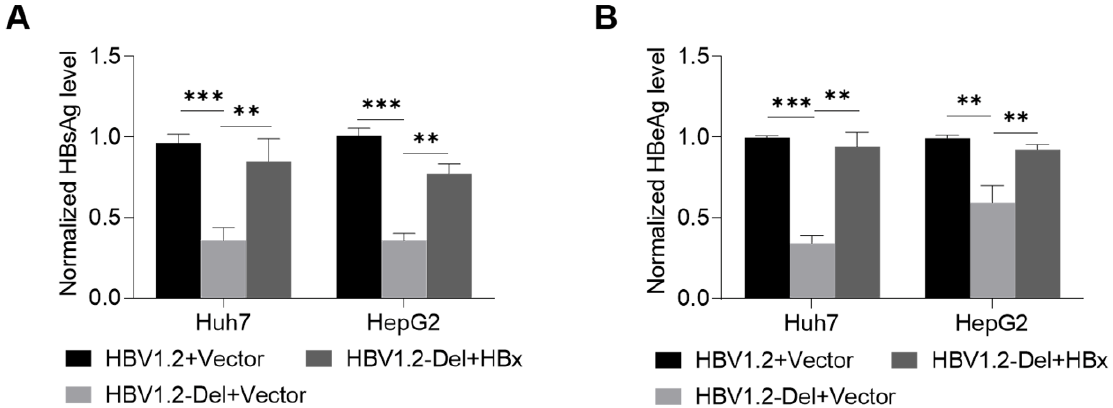
Figure 3. The effect of wild-type HBx protein on the x128–133del-weakened HBV replication. The pBB4.5-HBV1.2 or pBB4.5-HBV1.2-Del plasmid, pCDH-HBx-3 × flag or pCDH vector control plasmid, and pCDH-Nluc plasmid were co-transfected into the Huh7 and HepG2 cells (5 × 10 5 cells/well in 6-well plate), and then the levels of HBsAg ( A ) and HBeAg ( B ) in the culture supernatants of the Huh7 and HepG2 cells were detected by the chemiluminescence immunoassay at 72 h after co-transfection. ** p < 0.01, *** p < 0.001, Student’s t -test.